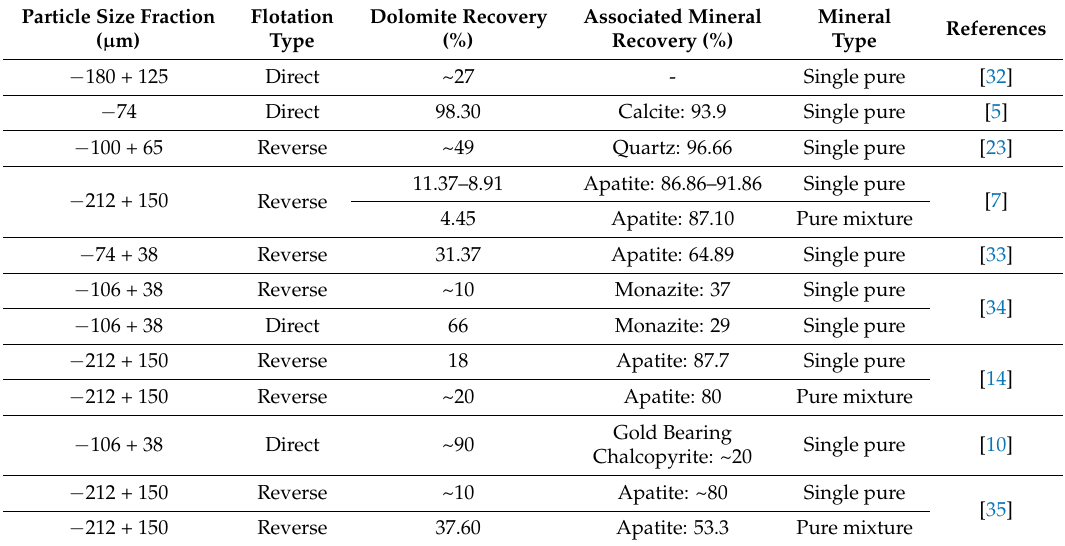
Table 1. Relationship between size and flotation recovery of dolomite and its associated